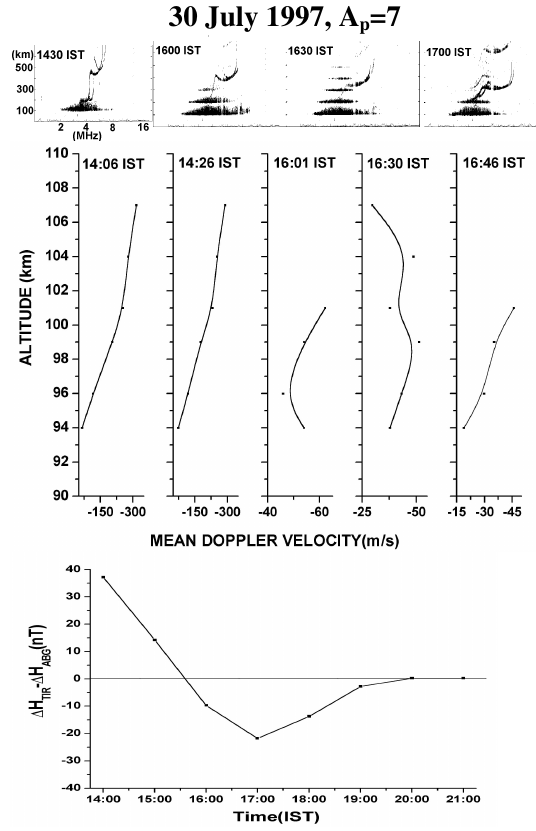
Fig. 9a. Height profiles of the VHF radar measured V p values at se- lected times on 30 July 1997 (middle panel) with the representative ionograms during this time. The strength of the equatorial electrojet during 14:00–21:00h is also shown in the figure (bottom panel).